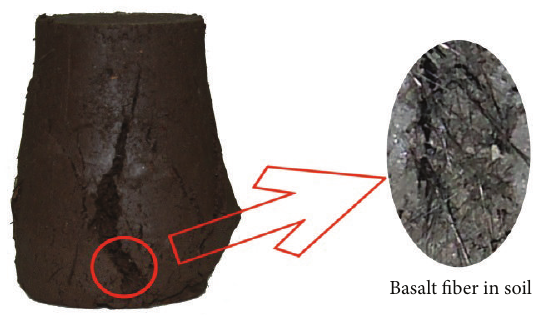
Figure 5: Failure form of basalt fiber reinforced soil